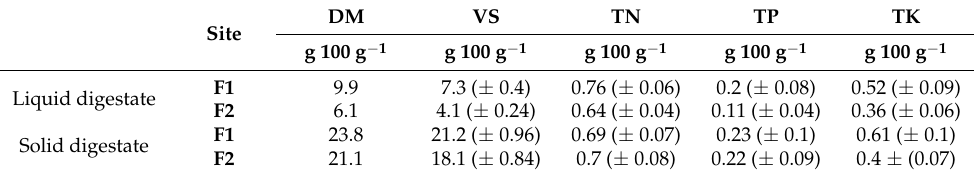
Table 3. Digestate characteristics during the experimentation at farm 1 (F1) and farm 2 (F2).